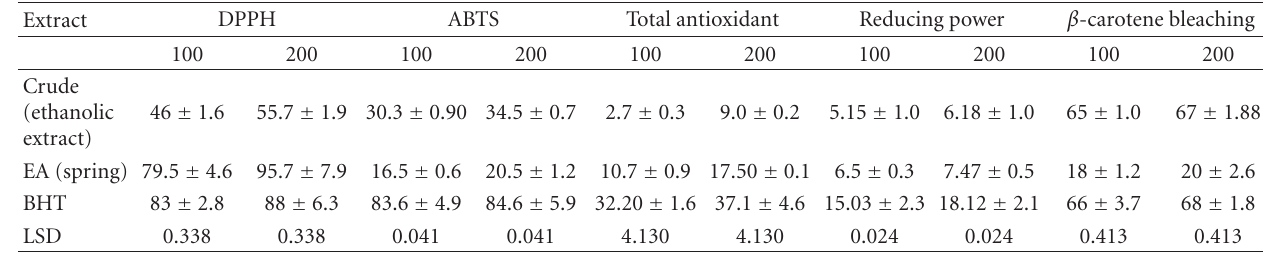
Table 5: Antioxidant activity (%) of algal crude extract, spring-collected ethyl acetate (EA) extract and standard BHT by di ff erent antioxidant methods at 100 and 200 μ g/mL.